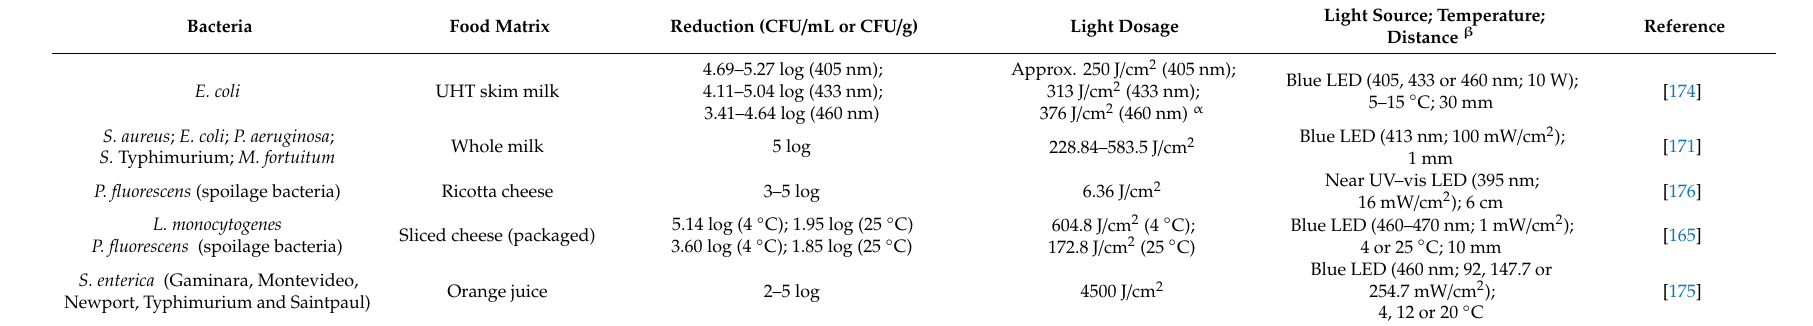
Table 2. Blue light inactivation of pathogenic bacteria on dairy